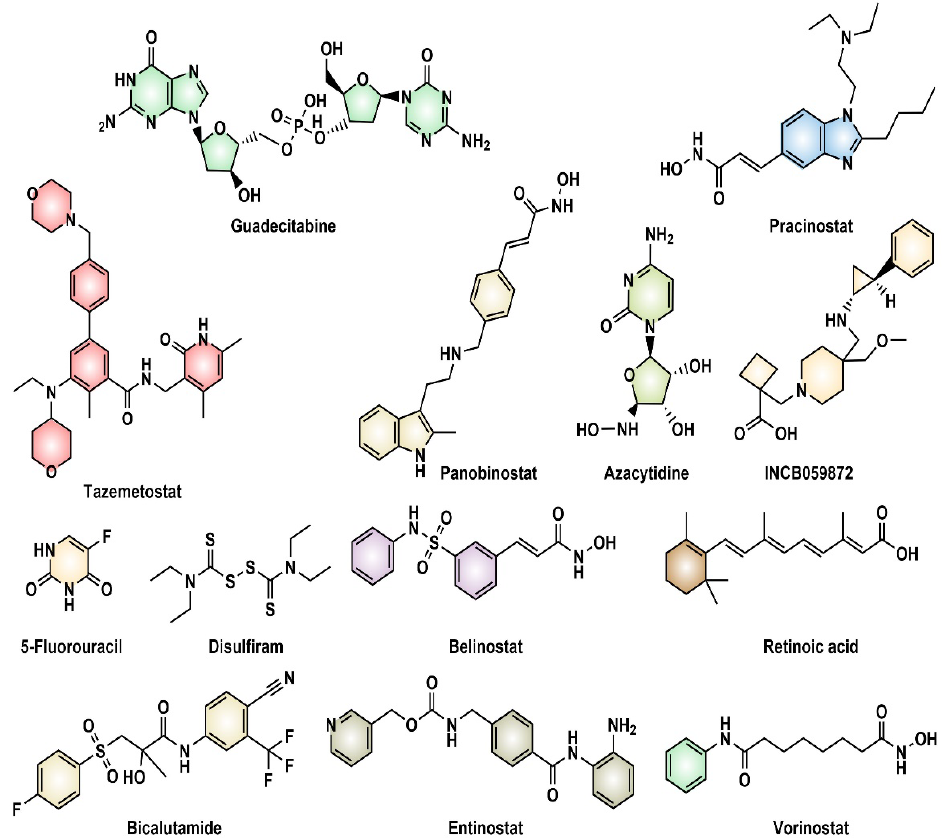
Figure 4. Some epigenetic inhibitors that have shown activity in prostate